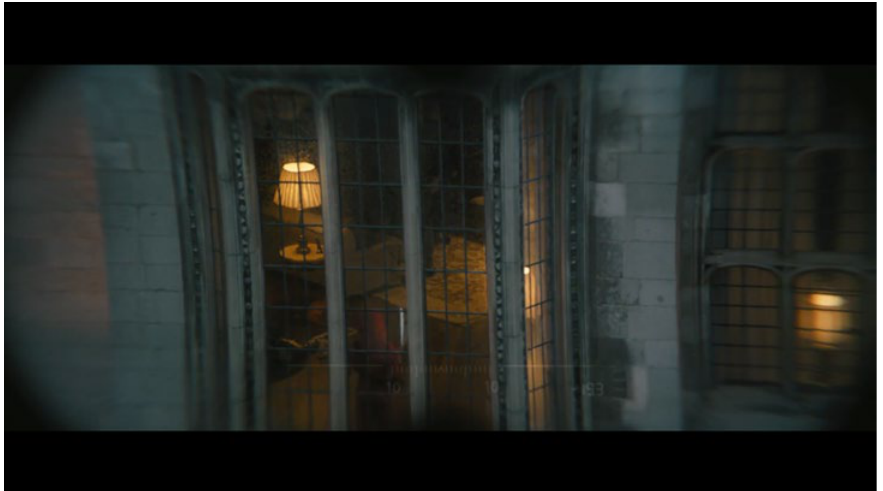
Figure 3 Riddler watching the Presidential candidate's